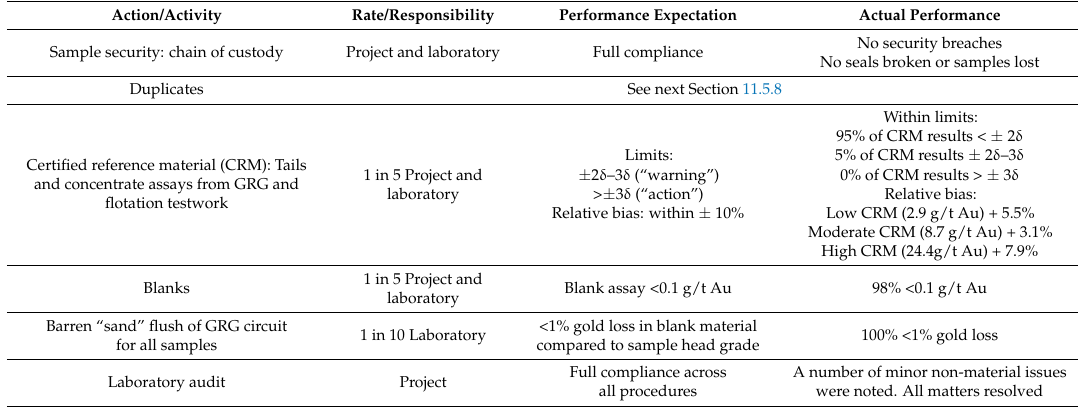
Table 21. Summary of corrective programme